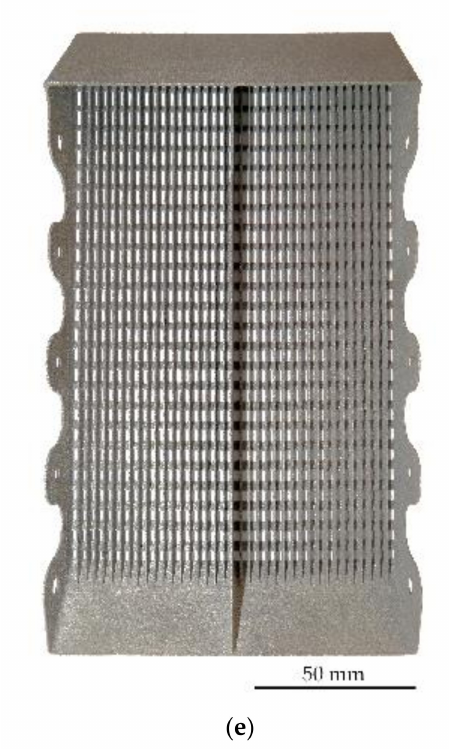
Figure 2. 3D models and built samples: ( a ) a model of the locking washer of the quarter-turn locking mechanism; ( b ) a model of the protective grille module of the air intake; ( c ) a built sample of the locking washer, side view; ( d ) a built sample of the locking washer, top view; ( e ) a built sample of the grille